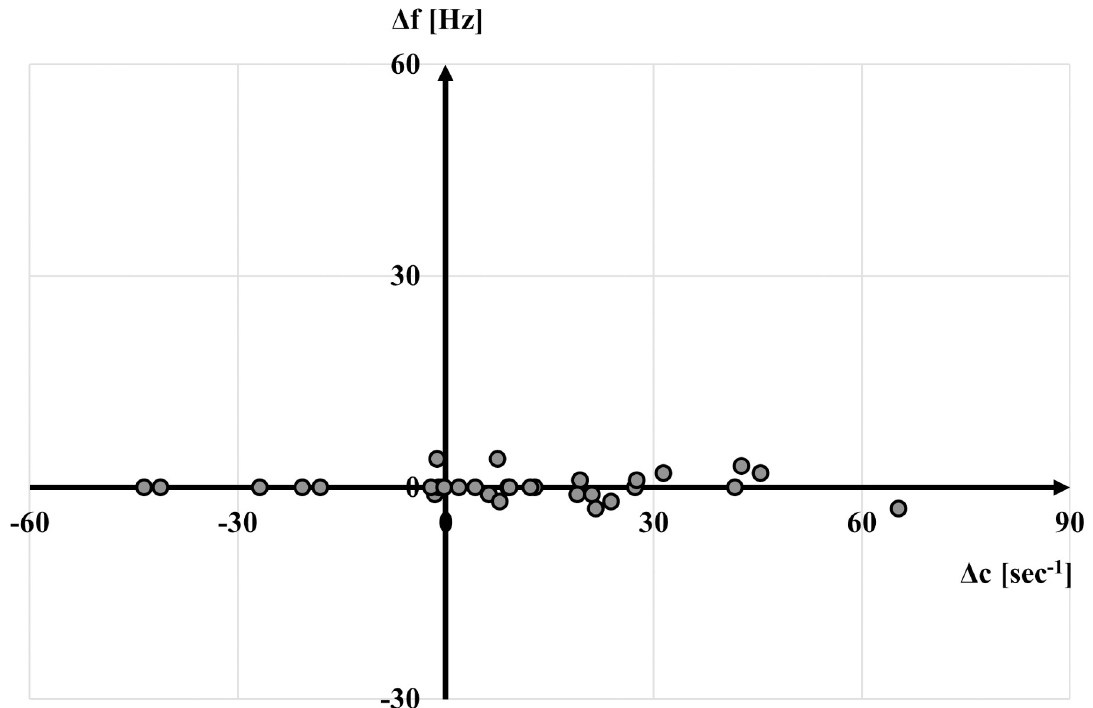
Fig 4. Differences (shoe hard–shoe soft) between two shoe conditions regarding dominant vibration frequency (f) and damping coefficient (c) in the gastrocnemius medialis (n = 32).